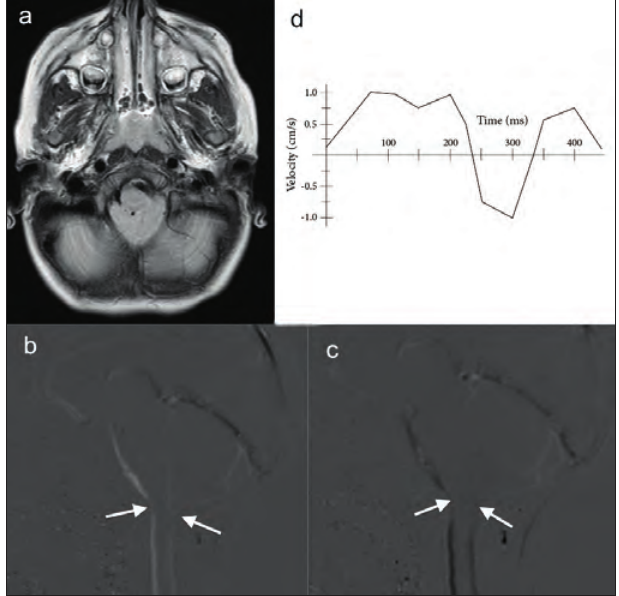
Fig. 4. A patient with Chiari I demonstrates (a) crowding of the foramen magnum by cerebellar tonsillar descent with (b) bi-directional flow that is severely restricted at the foramen magnum (white arrows). Graphic representation (c) demonstrates low peak velocities of equal volume during systole and diastole as well as short systolic duration.